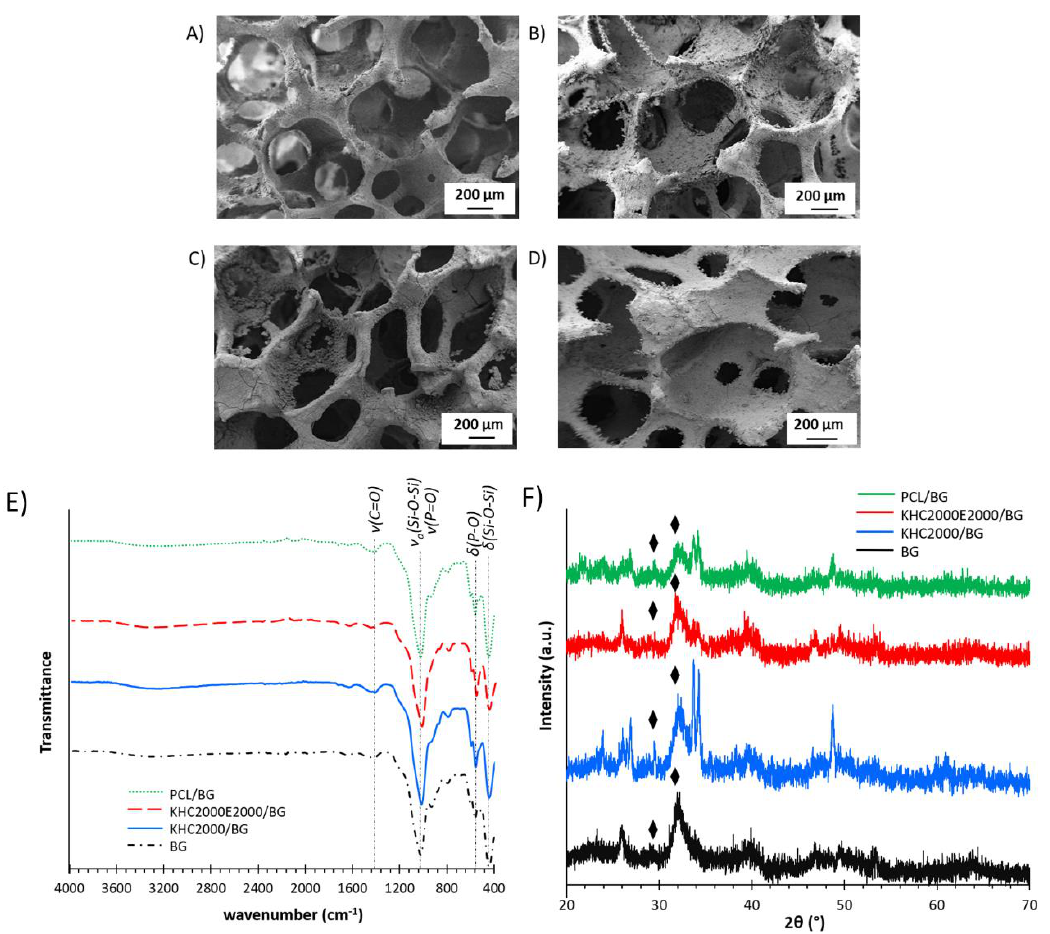
Figure 9. SEM images of ( A ) BG scaffold, ( B ) PCL/BG scaffold, ( C ) KHC2000/BG scaffold, ( D ) KHC2000E2000/BG scaffold after 21 days immersion in SBF. ATR-FTIR ( E ) and XRD ( F ) spectra of BG, PCL/BG, KHC2000/BG, and KHC2000E2000/BG scaffolds after 21 days immersion in SBF. The symbol identifies the characteristic peaks of the deposited crystalline HA at 2Θ values of 26° and 32°.